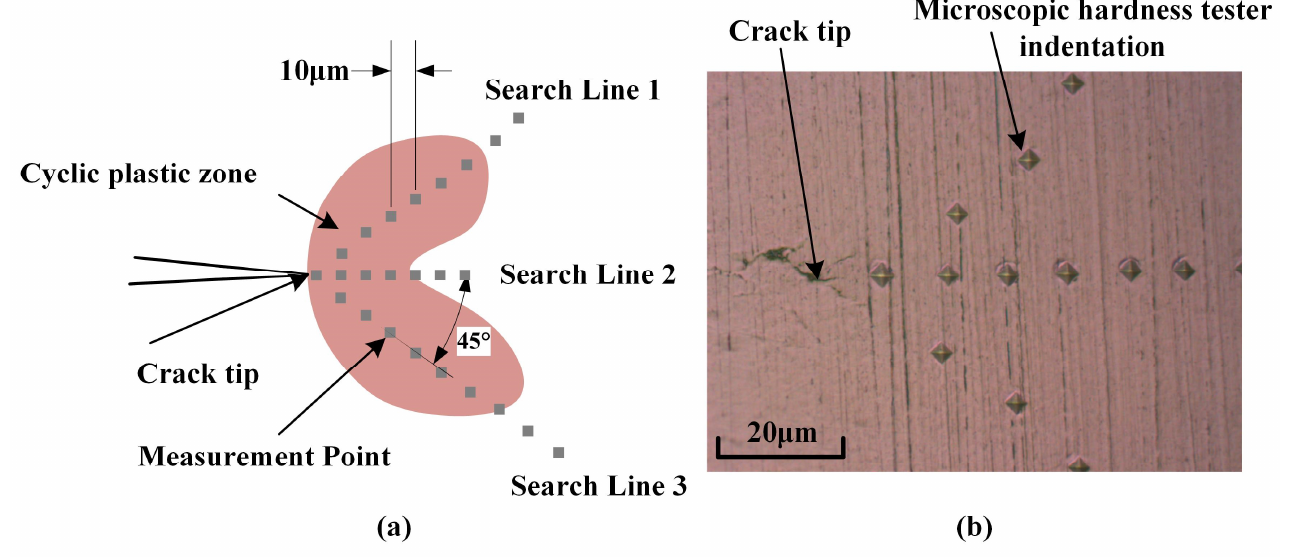
Figure 16. Micro-hardness measurement points position: ( a ) Schematic diagram of hardness meas- uring points layout; ( b ) the actual indentation of the measuring points.